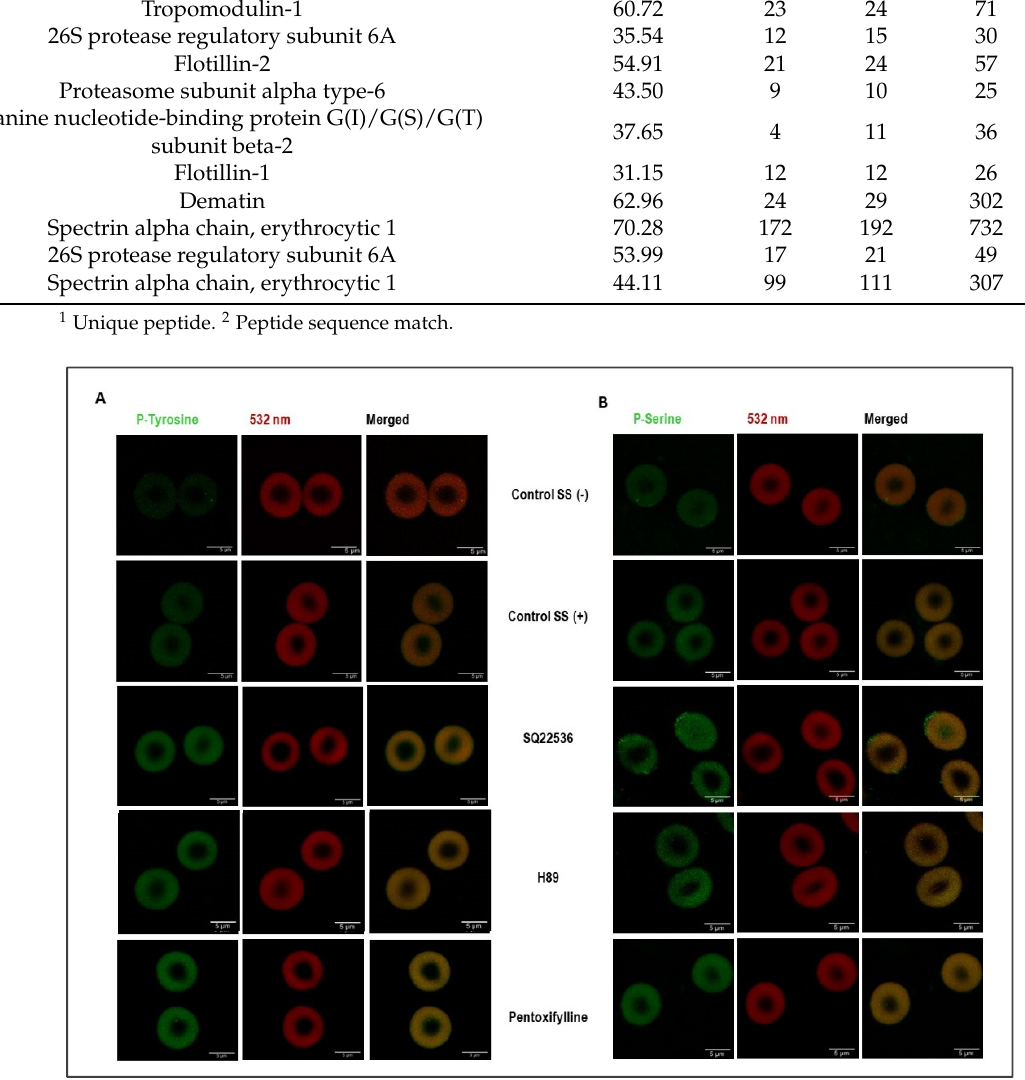
Figure 4. The changes in the phosphorylation status of RBCs due to different treatments. Tyrosine and serine phosphorylation are shown in green (488 nm) in panels ( A , B ), respectively. Physiological shear stress slightly increased both tyrosine and serine phosphorylation in RBC membrane proteins (Figure 5). Phosphorylated protein bands were also excised and analyzed in an independent run by LC-MS/MS. We identified spectrin, band 3, protein 4.1, protein 4.2, 55 kD erythrocyte membrane protein, dematin and tropomodulin to be phos- phorylated. We evaluated the changes in serine and tyrosine phosphorylation in RBC membrane proteomes due to different treatments. Accordingly, the inhibition of adenylyl cyclase by SQ22536 significantly increased tyrosine phosphorylation ( p < 0.05) but did not alter serine phosphorylation. The inhibition of PKA by H89 dihydrochloride increased tyrosine phosphorylation but did not significantly change serine phosphorylation of